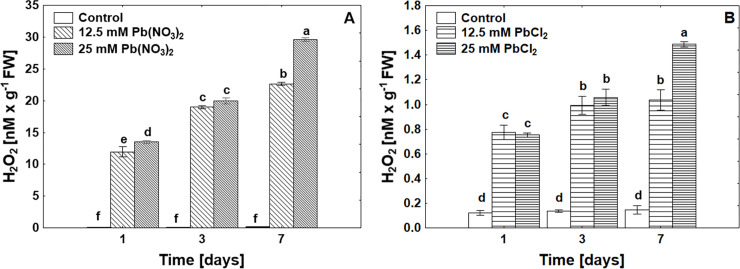
Hydrogen peroxide (H2O2) levels in P. sylvestris seeds under control, Pb(NO3)2 (A) or PbCl2 (B) treatments in concentrations of 12.5 mM and 25 mM after 1, 3 and 7 days of germination, ANOVA, Duncan Test p≤0.05.